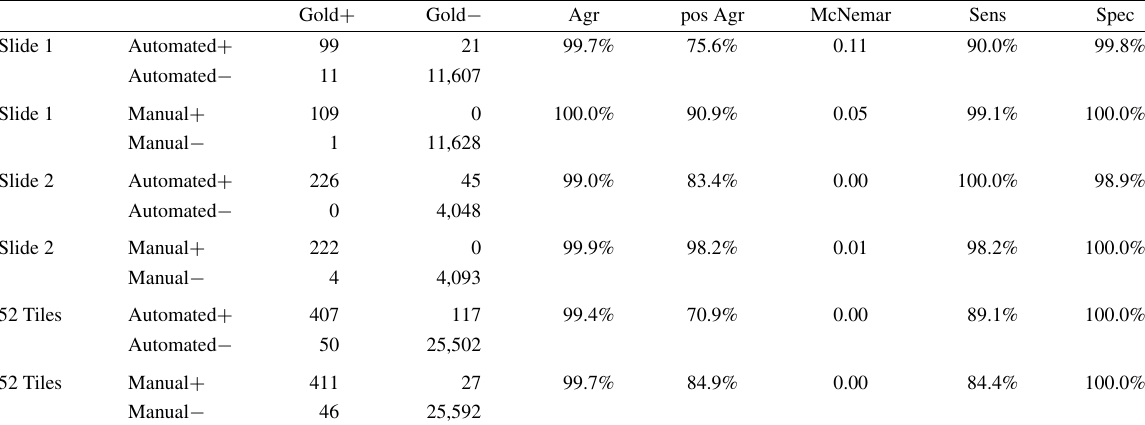
Statistical analysis of classification algorithm. In 2 complete slides as well as in 52 tiles from different slides, automated and manual detection of p16-stained cells was compared. Gold + / − denotes the number of cells or cell clusters rated positive/negative after 3 pass analysis of the same slide (2 manual and 1